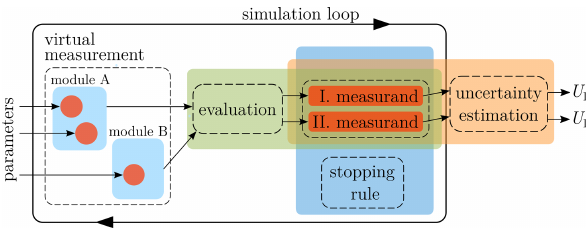
Figure 1. Proposed structure of D-MTs for uncertainty estimation, derived from the generalization of the